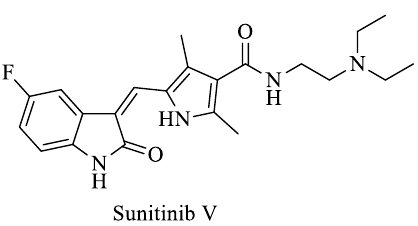
Fig. 2. Isatin derivatives as anti-cancer activity (Yousef et al., 2020)